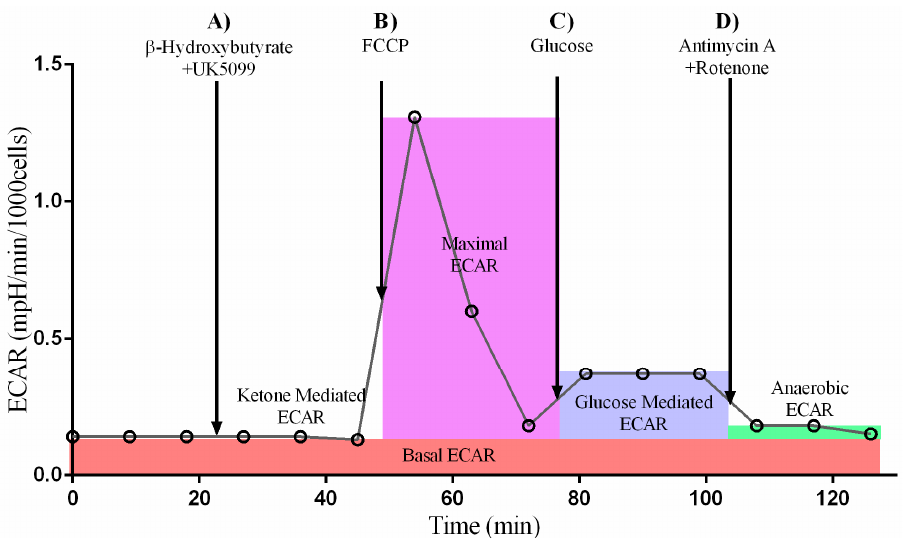
Figure 2. Schematic representation of the ketone stress test (KST) for assessing glycolysis in terms of extracellular acidification rate (ECAR).